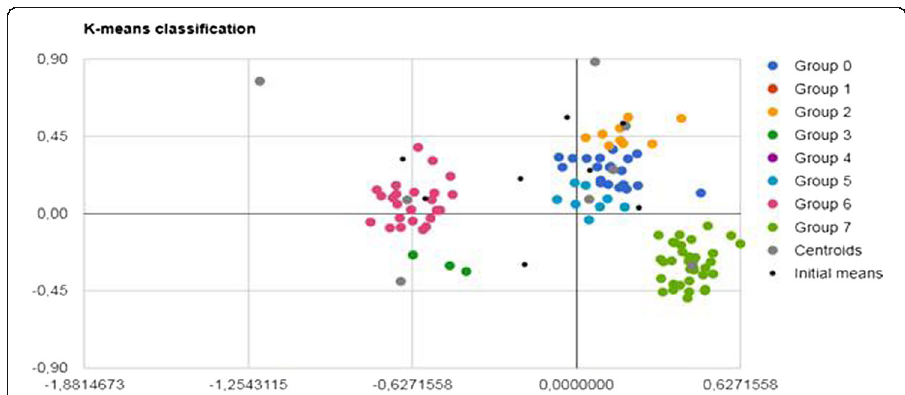
Fig. 7 A classification of learner in